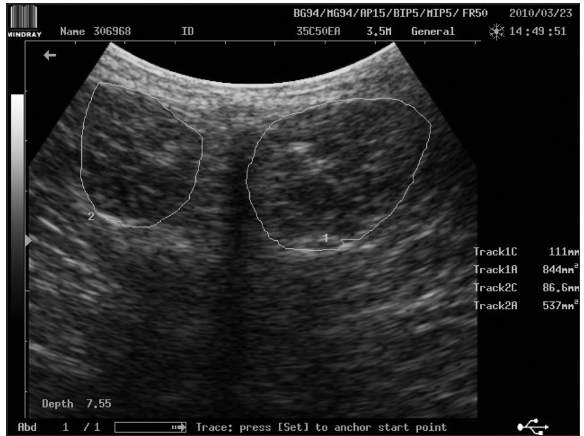
Figure 2: Left and Right Side of Lumbar Multifidus Asymmetrical with Ultra sound Imaging A CSA of 537mm² (5.37cm²) on the left side and 844mm² (8.44cm²) on the right side were noted. The asymmetry indicate atrophy or pathology in the LM muscle.